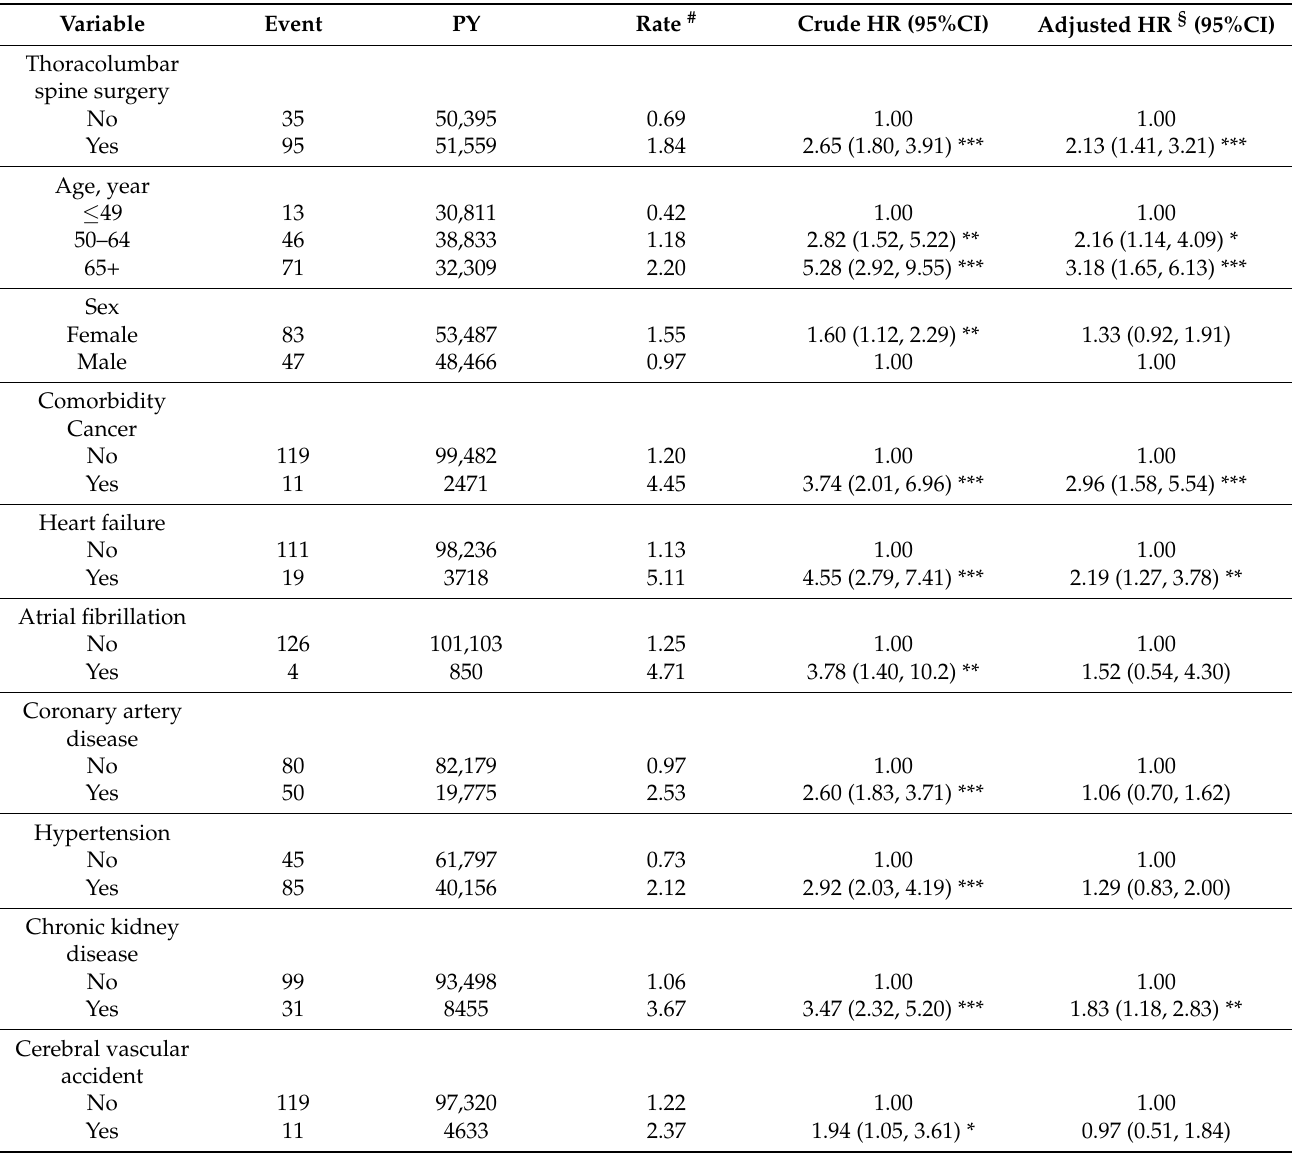
Table 2. Incidence and Hazard ratio for VTE and VTE-associated risk